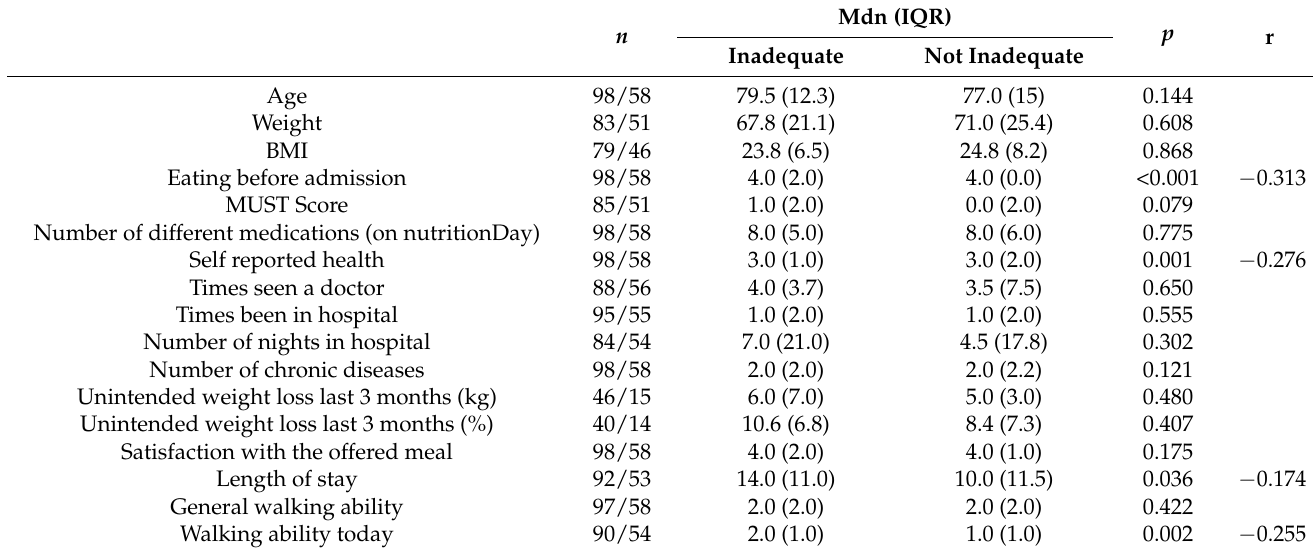
Table 5. Group comparison inadequate food intake (Mann-Whitney-U